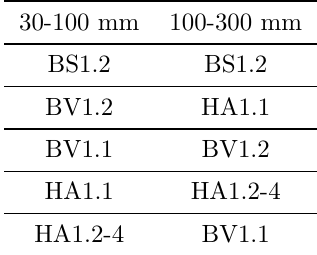
Table 1. Measuring places line-up according to gra- dient.